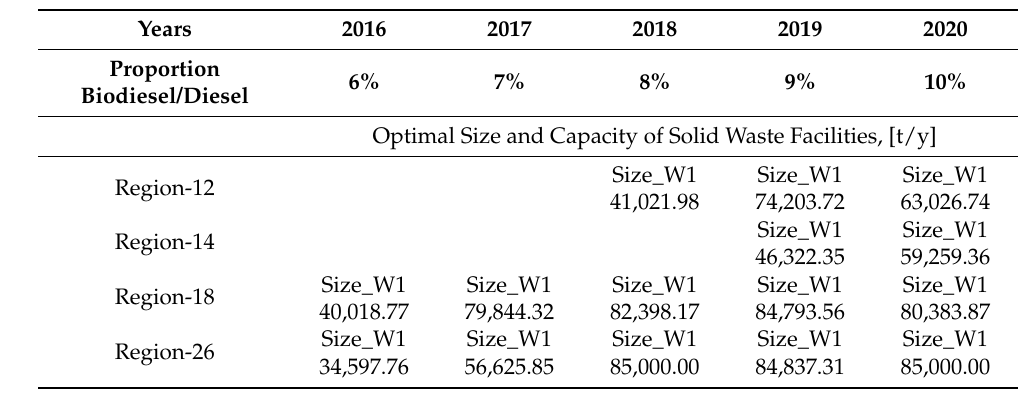
Tables 11 and 12 represent the obtained results using the two main criteria: (A) Mini- mum total greenhouse gas emissions and (B) Minimum total annual costs. Table 11. Results obtained from the optimization problem solution using criterion: (A) Minimum total greenhouse gas